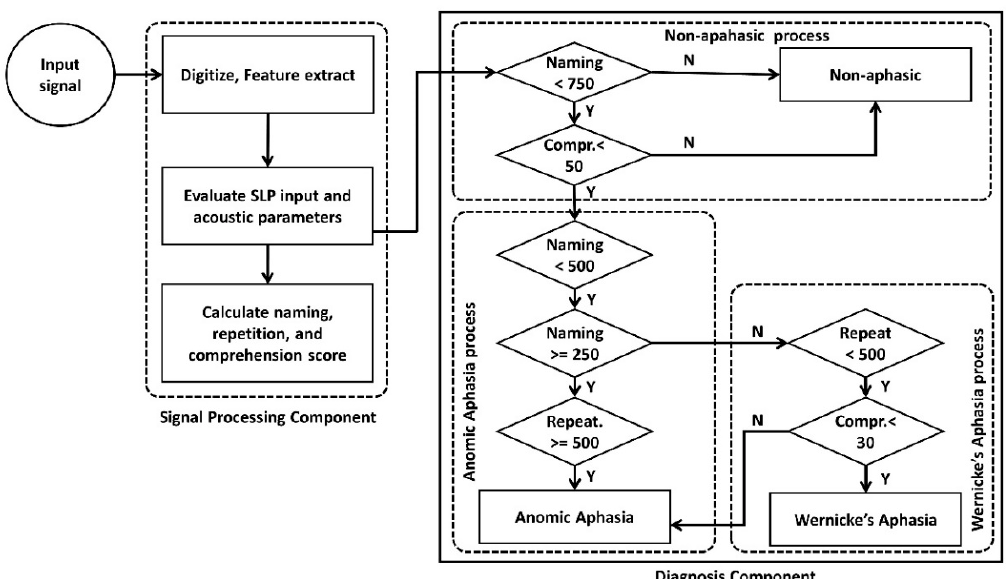
Figure 3. Algorithm for the differential diagnosis of Anomic and Wernicke's